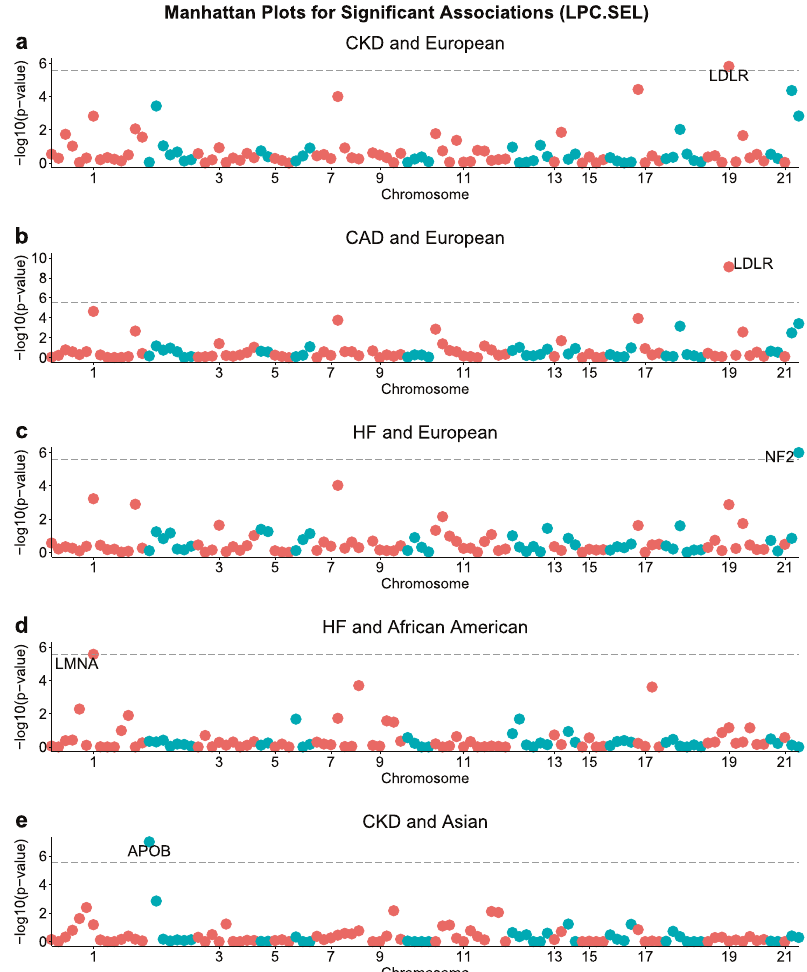
Fig. 6 Exome-wide signi fi cant gene-based test results for 107 autosomal genes on the eMERGE-seq panel using LPC with pre-selected phecodes for six diseases. Results are shown for those phenotypes and ethnic groups with at least one exome-wide signi fi cant result: a CKD and European, b CAD and European, c HF and European, d HF and African American, e CKD and Asian. The horizontal line corresponds to the exome-wide signi fi cance